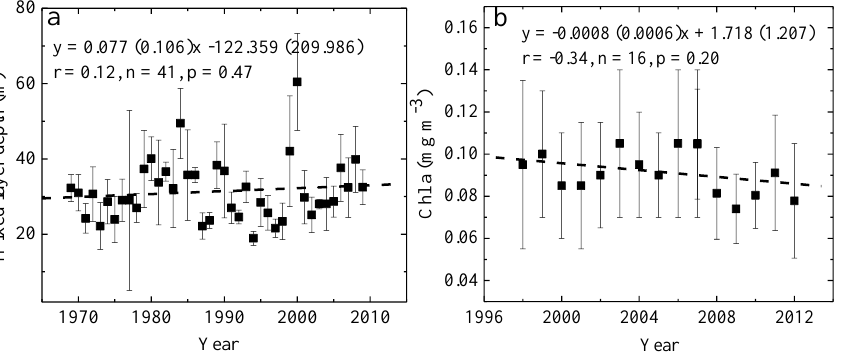
Figure 10. Temporal changes in mixed layer depth (a) , and Chl a ( b ). Squares show the mean value, and bars show the standard deviation. See Table 2 for more details on data sources. All data are from the same month